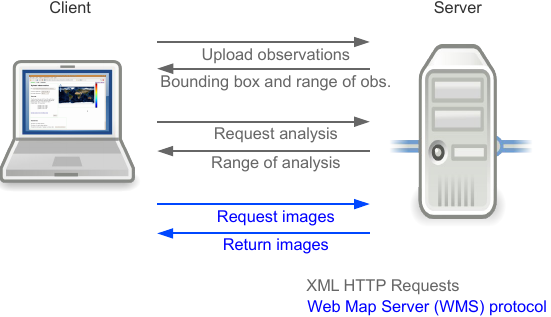
Fig. 2. Exchanges between client and